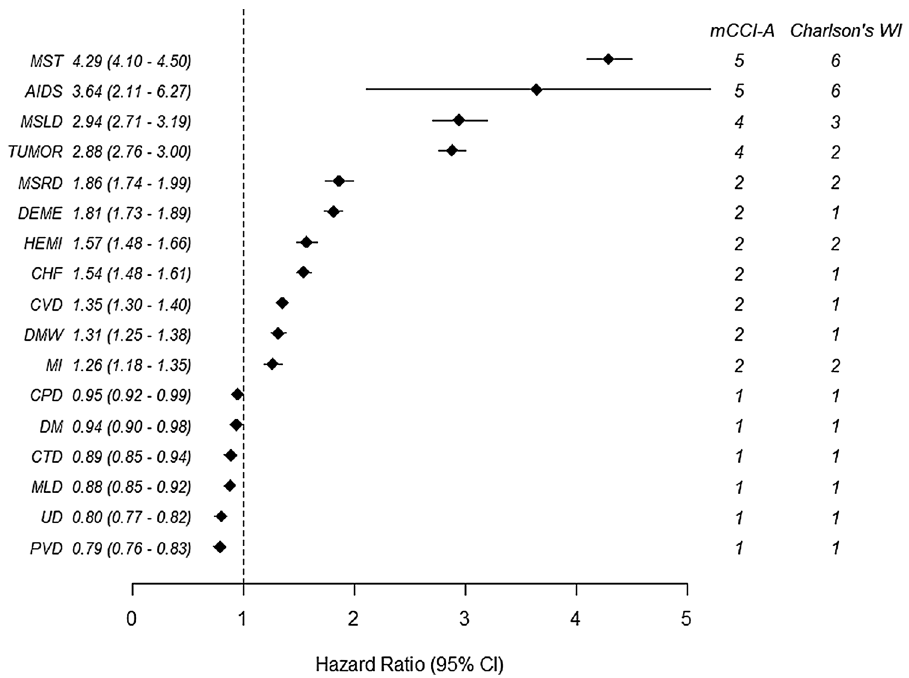
Figure 1. Adjusted hazard ratio and weights of 17 comorbidities in the development cohort. MST, Metastatic solid tumor; AIDS, Acquired immunodeficiency syndrome; MSLD, Moderate or severe liver disease; MSRD, Moderate or severe renal disease; DEME, Dementia; HEMI, Hemiplegia, CHF, Congestive heart failure, MI, Myocardial infarction; CVD, Cerebrovascular disease; DMW, Diabetes mellitus with end organ damage; DM, Diabetes mellitus; CPD, Chronic pulmonary disease; MLD, Mild liver disease; CTD, Connective tissue disease; UD, Ulcer disease; PVD, Peripheral vascular disease. Adjusted for age (quartile), sex, region, family income ratio (11 groups), and all